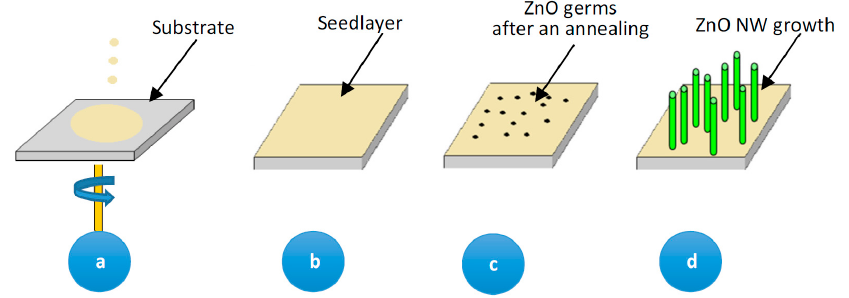
Figure 1. Schema of the ZnO nanowire formation: (a) Spin-coating of the seedlayer solution; (b) seedlayer based on the polyvinyl alcohol (PVA) and Zn(CH 3 COO) 2 · 2H 2 O; (c) ZnO nanocristallites formation after an annealing at 500 °C during 3 h; (d) undoped and Fe-doped ZnO nanowire (ZnO NW) growth at 95 °C during 4 h.